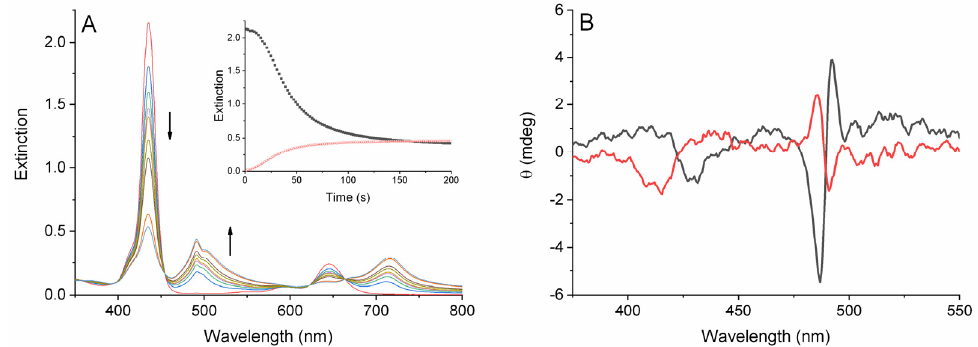
Figure 2. ( A ) UV/Vis extinction spectral changes and relative kinetic profiles (inset) at 492 nm (red trace) and 434 nm (black trace) for the aggregation of TPPS 4 induced by adopting the modified PF mixing order protocol (see text) in the presence of L-Arg. Experimental conditions: [TPPS 4 ] = 10 µ M; [H 2 SO 4 ] = 0.5 M; [L-Arg] = 0.1 M, T = 298 K, cell path length 0.5 cm. The solid lines are the best-fitting of the experimental extinction data to Equation (1) (see text). ( B ) CD spectra for the final aggregated samples obtained in the presence of L (red trace) and D-Arg (black trace).